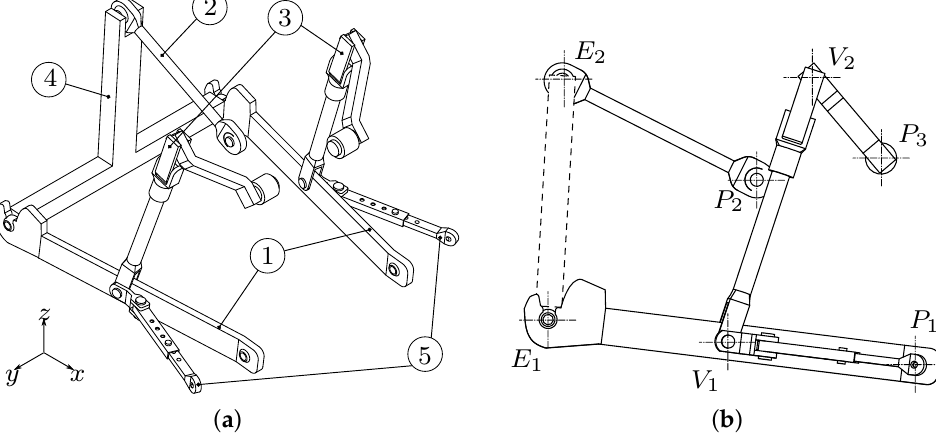
Figure 2. Rear-mounted three-point linkage: ( a ) assembly; ( b ) boundary nodes of the reduced- order